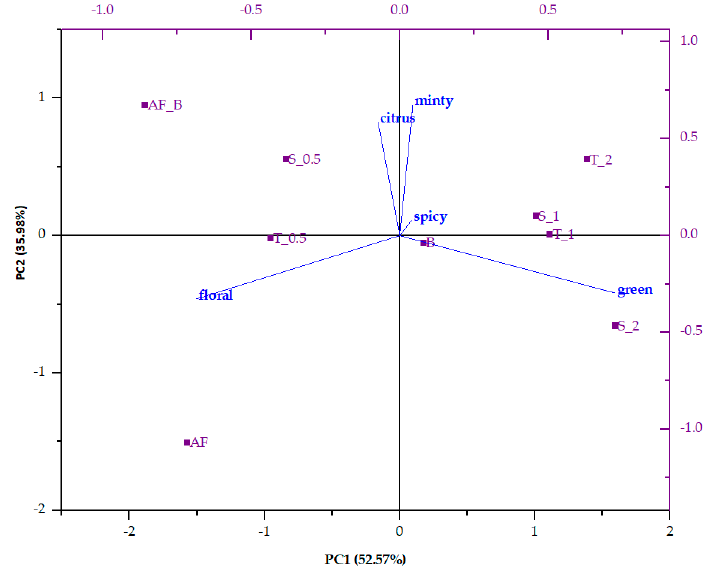
Figure 2. Principal component analysis (PCA) biplot of volatile compounds in blackberry